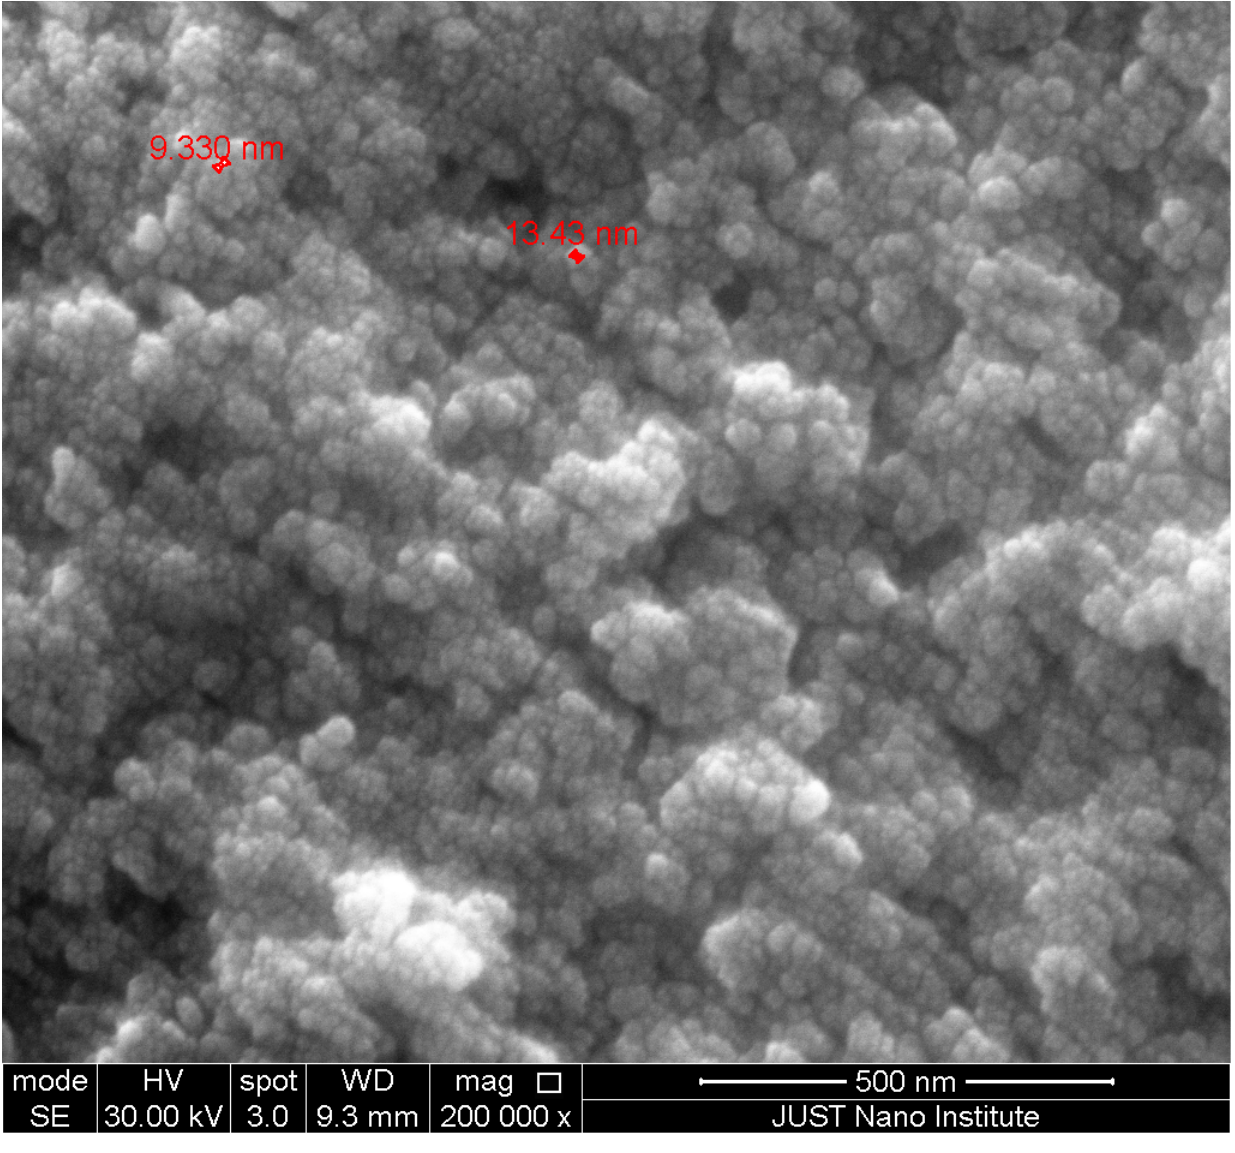
Table 1. Constituents of Sterculia diversifolia plant ethanolic extract as revealed by GC ‐ MS.